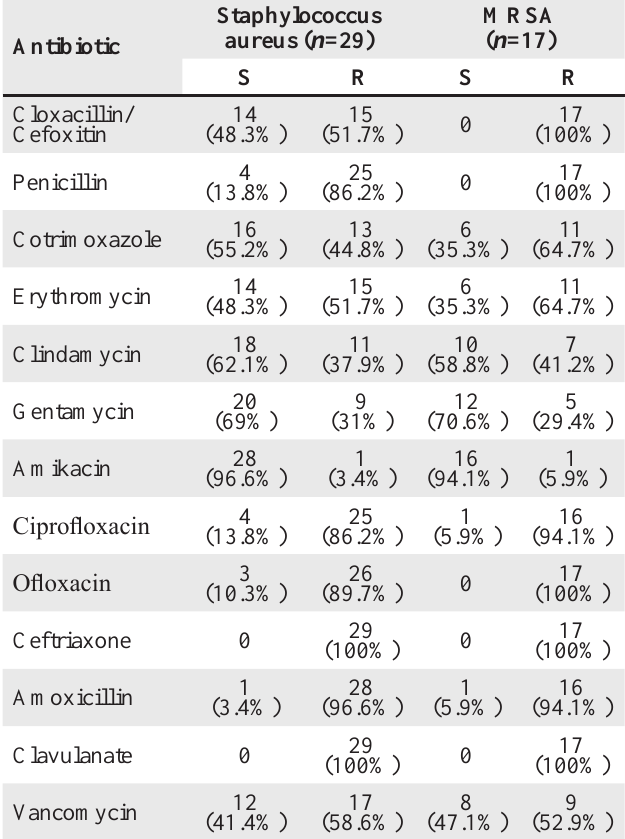
Table 1 : Antibiotic sensitivity of Staphylococcus aureus in post cesarean